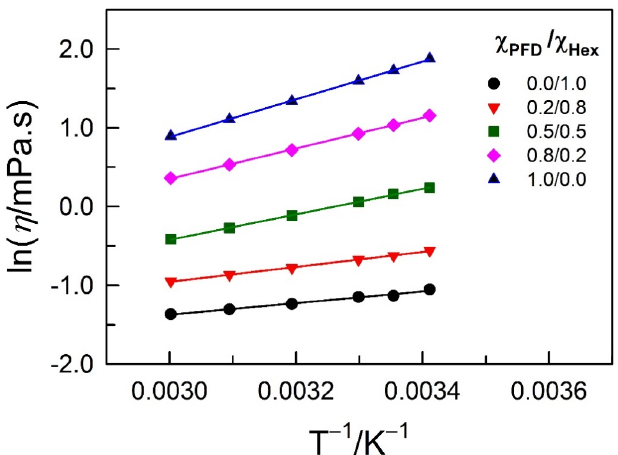
Figure 4. Variation in ln η of the investigated mixtures with T − 1 at different mole fraction ratios and at pressure p = 0.1 MPa. The solid curves represent the best fit to the Arrhenius model: ln ( η /mPa · s ) = ln ( A η ) + Ea , η . Parameters ln ( A η ), and E α , η , along with R 2 are reported in Table 5. Table 5. Summary of parameters associated with dynamic viscosity of the investigated mixtures according to the Arrhenius model using the equation: ln η = ln A η + Ea / RT . x PFD ln A η